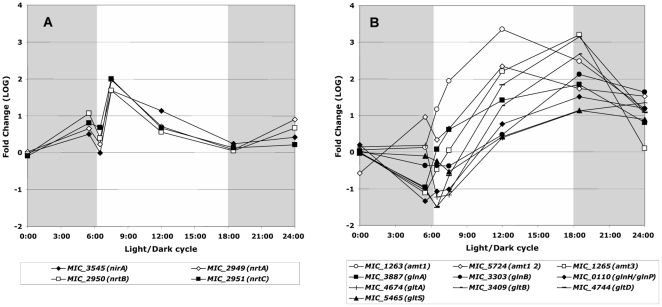
Significant variations in the transcript abundance of genes involved in nitrogen transport and metabolism during the light/dark cycle.
A. Nitrite reductase (nirA) and the nitrate/nitrite transport (nrt) genes. B. Ammonium permease (amt), transport and synthesis of glutamate (glt) and glutamine (gln) genes. The gray shaded part of the figure represents the dark period of the light/dark cycle.